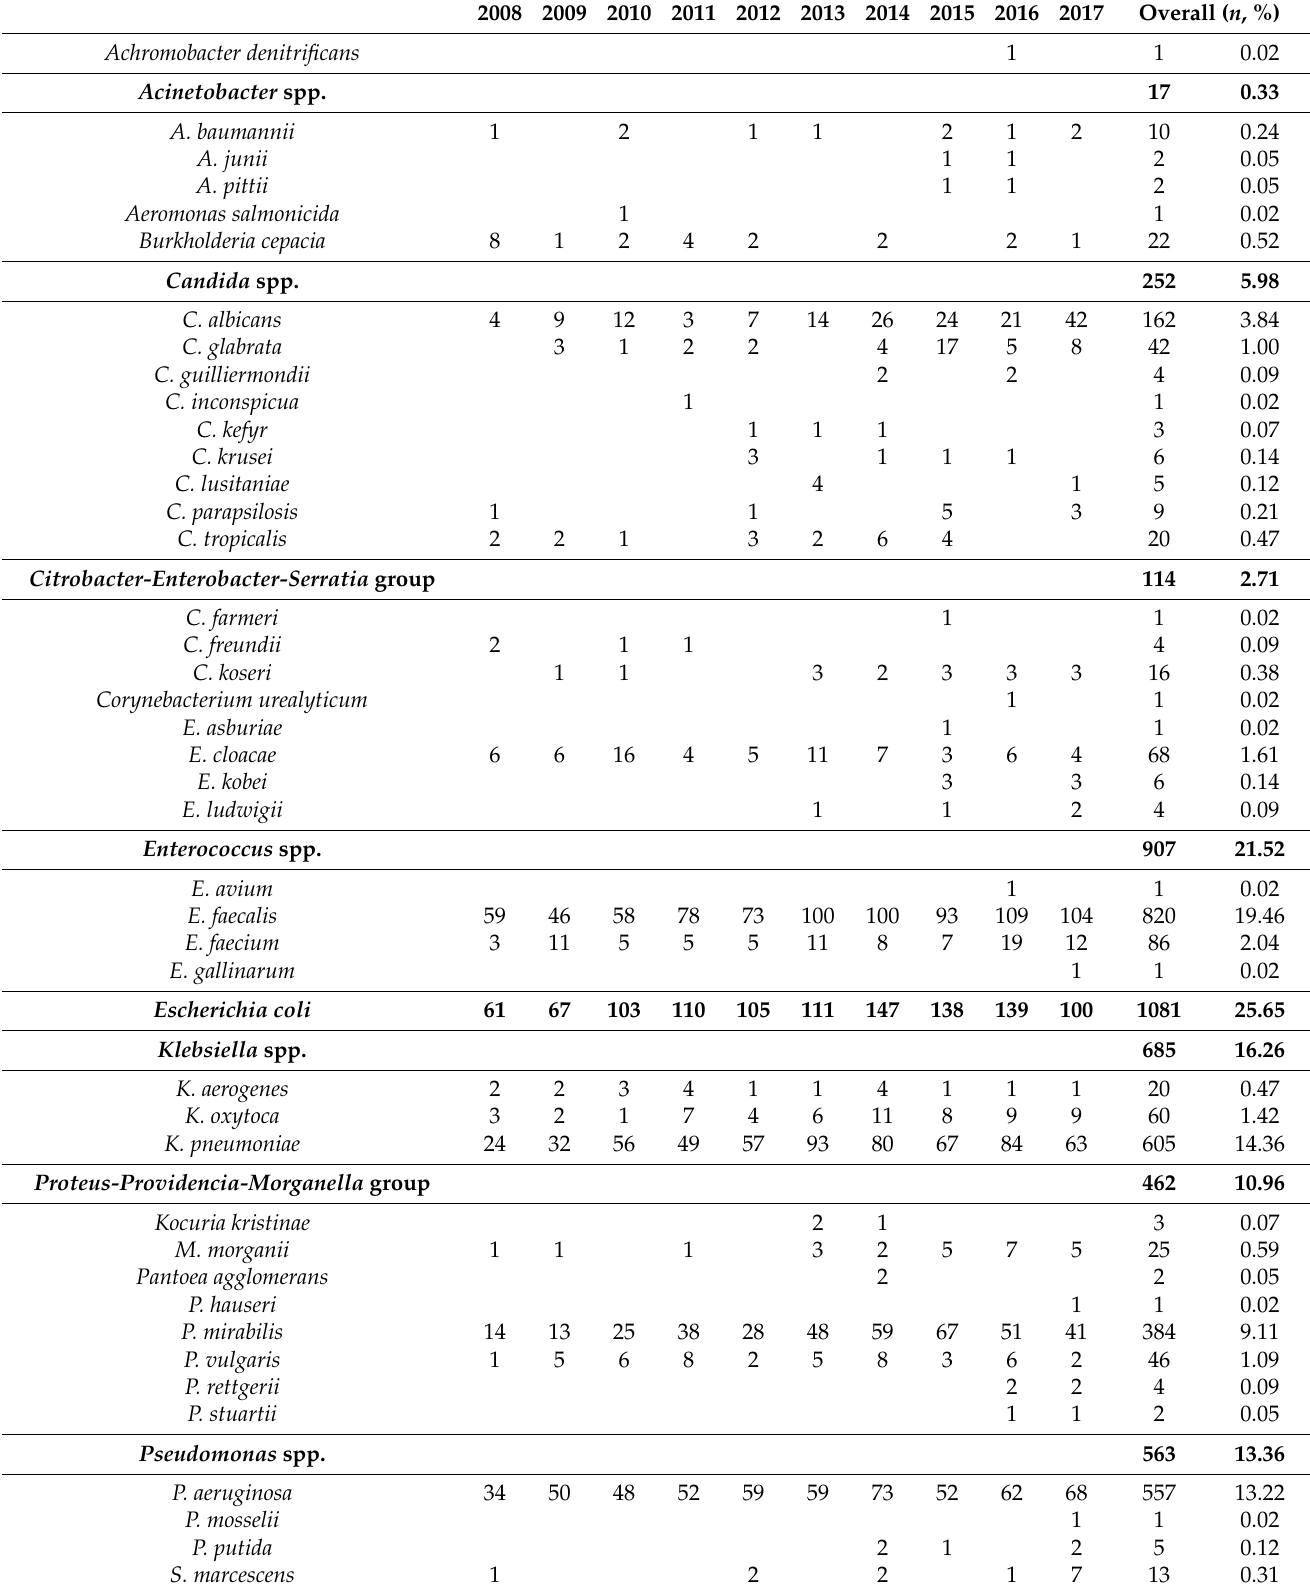
Table 3. Distribution of relevant pathogens from inpatient UTIs affecting elderly patients